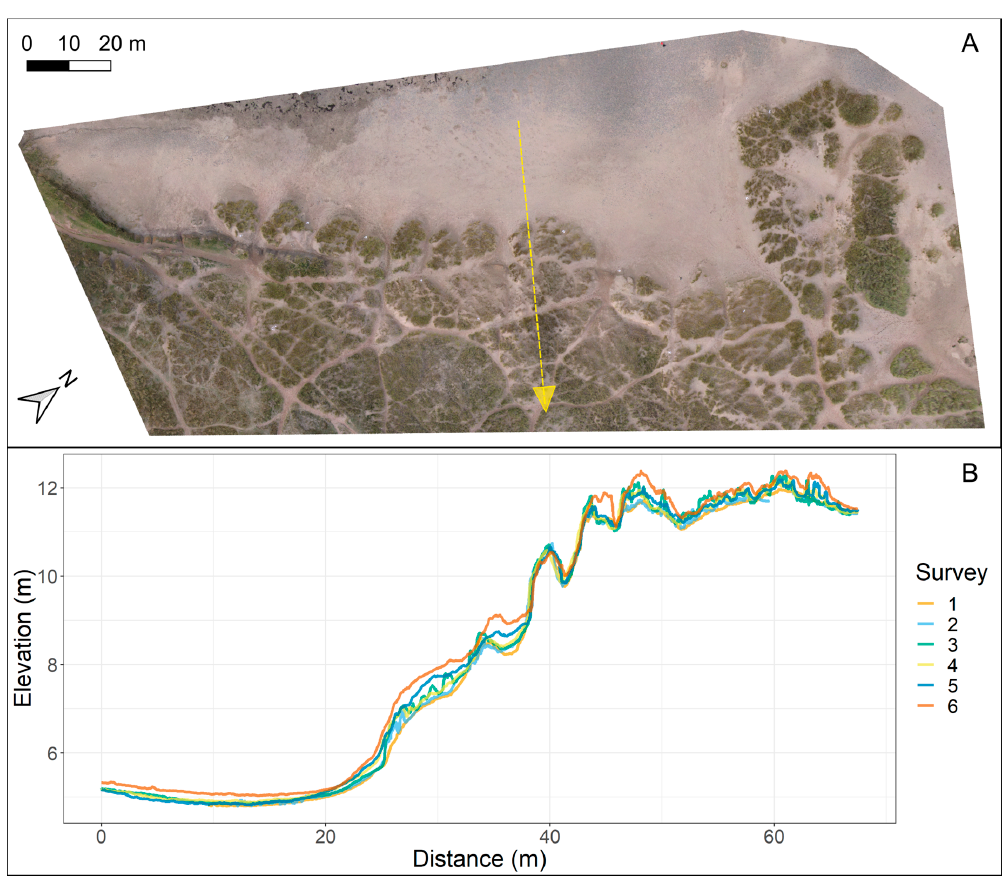
Figure 5. ( A ) Orthomosaic constructed with data from survey 5 (conducted on 16 June 2017) overlaid with a transect; ( B ) Elevation profiles of the transect constructed with data from DEMs of all 6 KAP